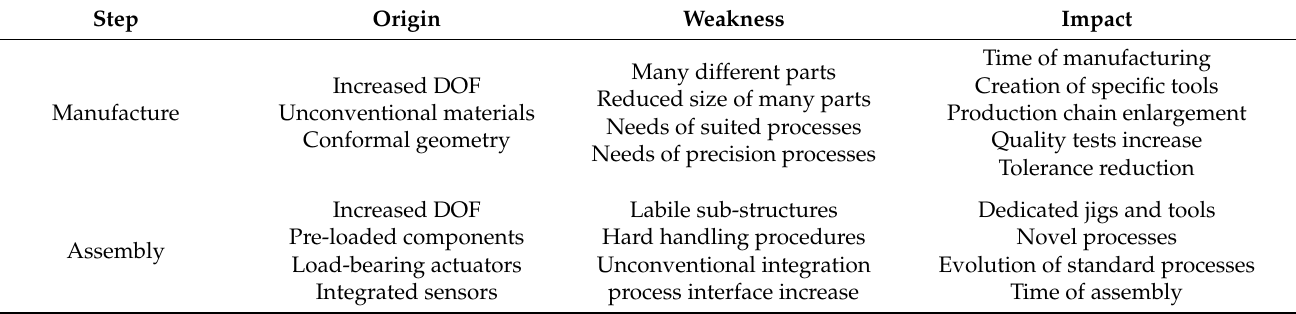
Table 3. Summary of weakness and criticalities of a morphing system—manufacturing and